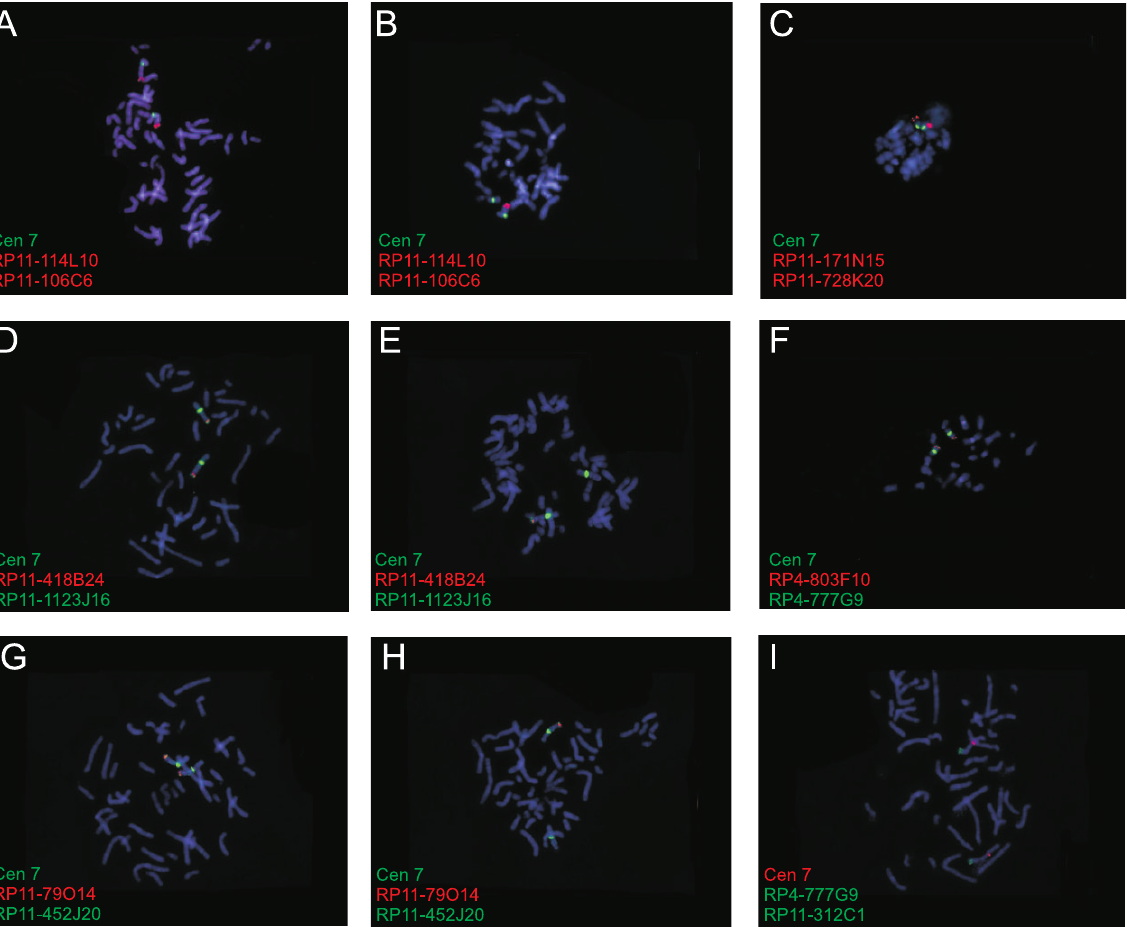
Figure 2. FISH analysis of the 7q35–q36 deletions in cell lines. A), D) and G) FISH analysis on cytogenetically normal controls with probes located within the 7q35–q36 deleted regions. B), E) and H) FISH analysis with probes located within the 7q35–q36 deleted regions on the cell lines Kasumi-3 (B), UCSD-AML1 (E) and MUTZ-3 (H). C), F) and I) FISH analysis with probes just outside of the 7q35–q36 deleted regions on the cell lines Kasumi-3 (C), UCSD-AML1 (F) and MUTZ-3